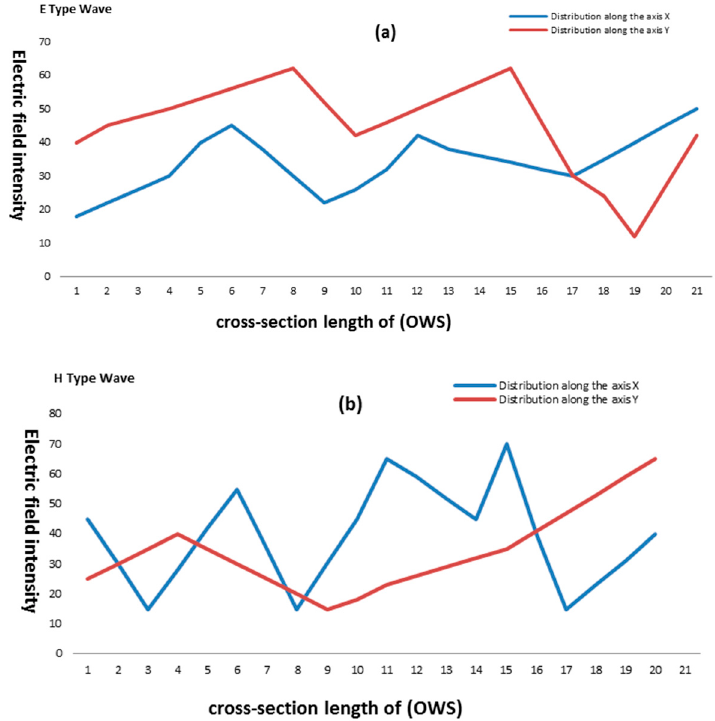
Figure 5. Dependencies between the electric field intensity and cross-section length of an OWS with air filling for E-type ( a ) and H-type ( b ) waves in the OWS.